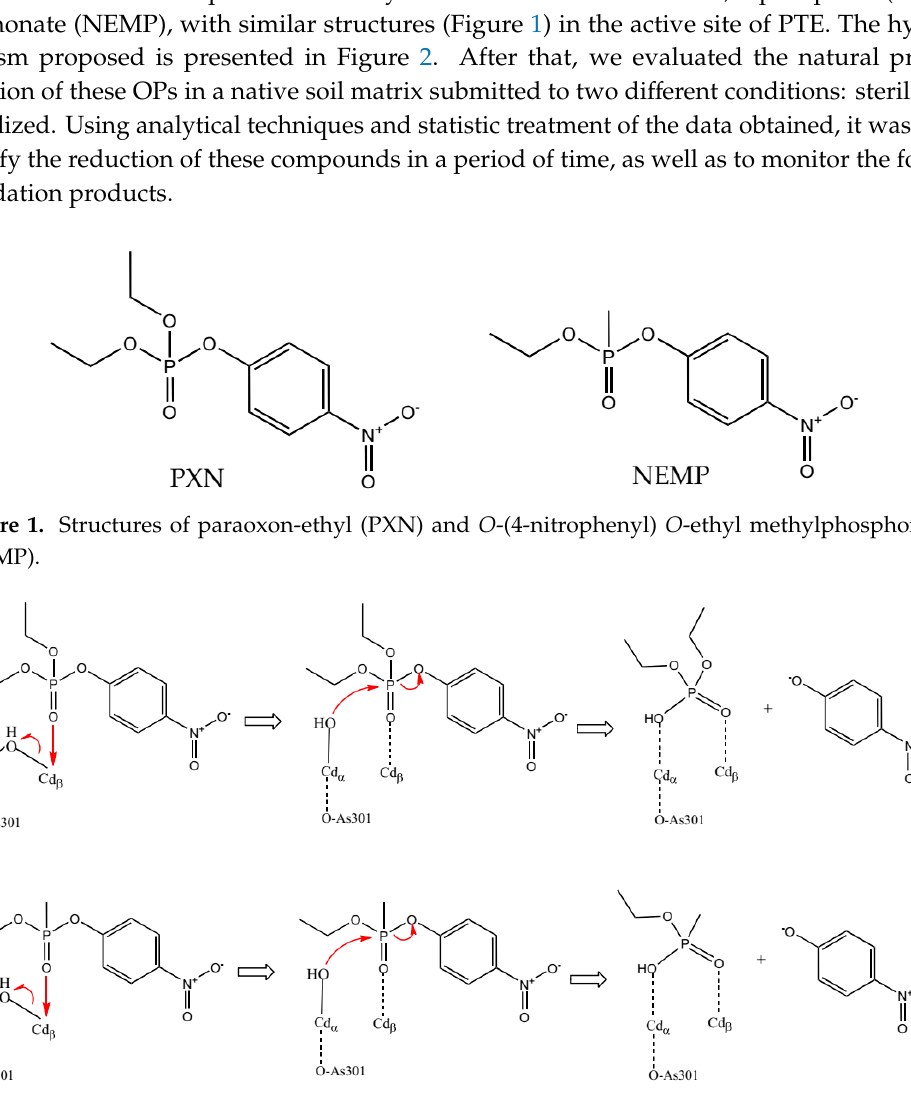
Figure 2. A proposed general pesticide-degrading mechanism for the phosphotriesterase (PTE)-catalyzed hydrolysis of PXN and NEMP. Adapted from Zhang et al. [26].